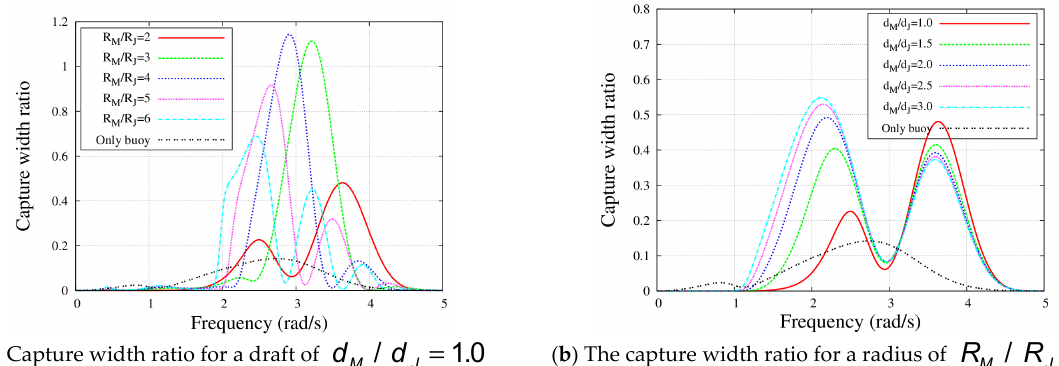
2.5(rad/s) ω= damping coefficients, when the wave frequency was , the first peak ap- peared in the capture width ratio of the moonpool float. With the increase in the PTO damping coefficient, the peak gradually decreased. When the wave frequency of 3.5(rad/s) ω= occurred, the second peak value appeared on the capture width ratio curve.